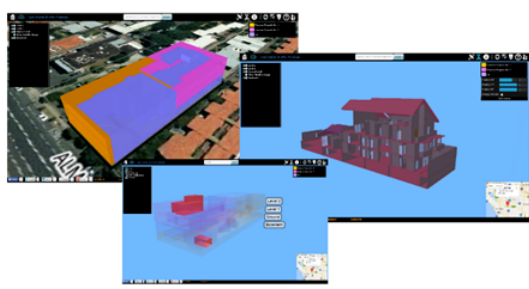
Figure 4. Land Use Victoria 3D ePlan prototype